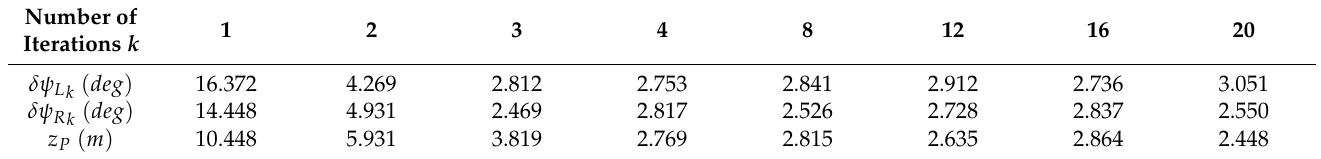
Table 4. Iterative process of parameter